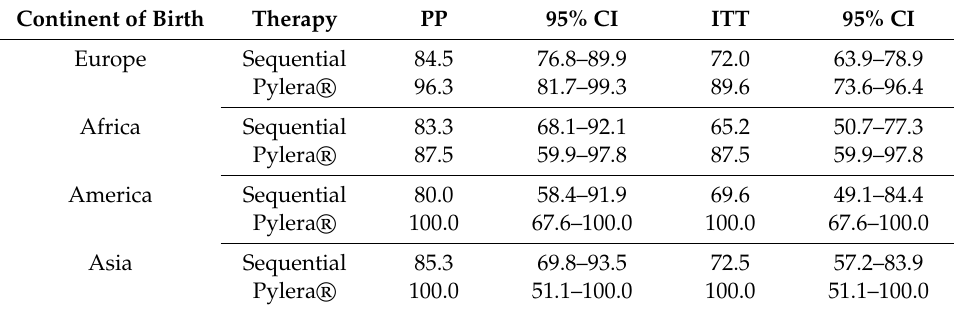
Table 5. Eradication rates according to the continent of